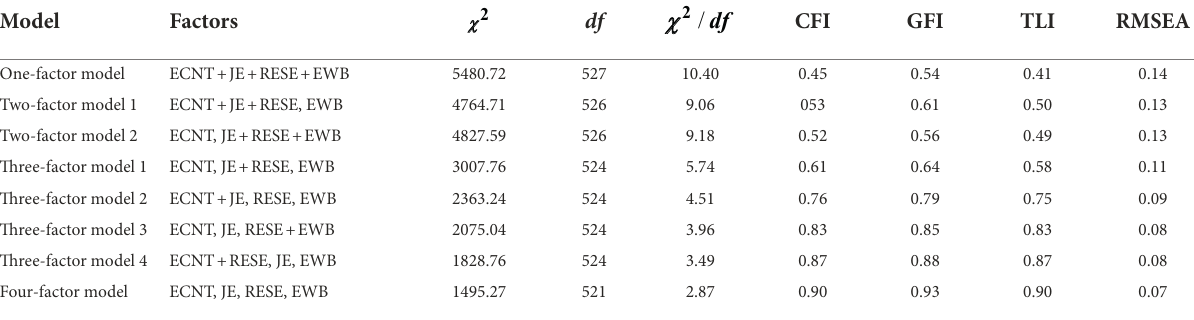
TABLE 2 The results of confirmatory factor analysis. Model